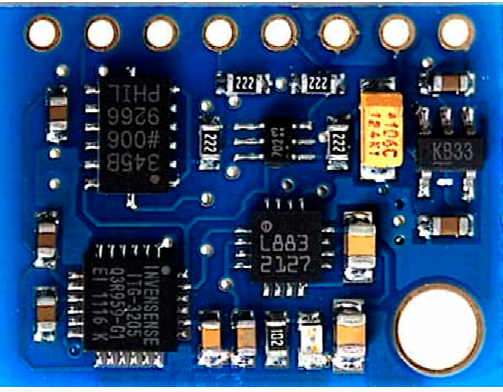
Figure 2. Micro electromechanical-inertial measurement unit (MEMS-IMU) product map.